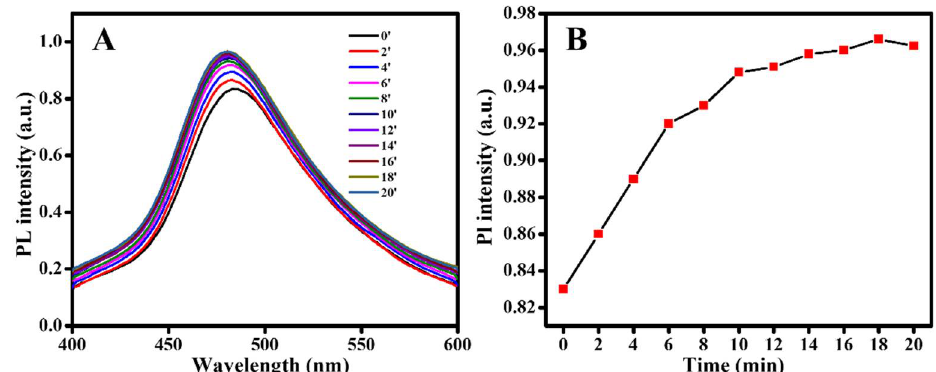
Figure 7. ( A ) Fluorescence spectra and ( B ) changes in the relative fluorescence intensity (I/I 0 ) of the NPCD/AgNP nanocomposties in the presence of MFH (10 µg/L) as a function of time.